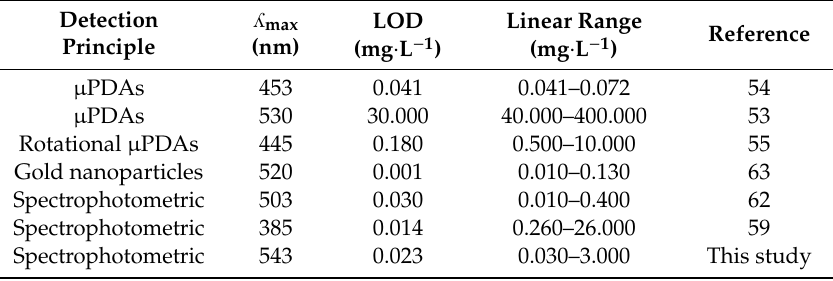
Table 5. Comparison of spectrophotometric methods of the Cr VI determination.